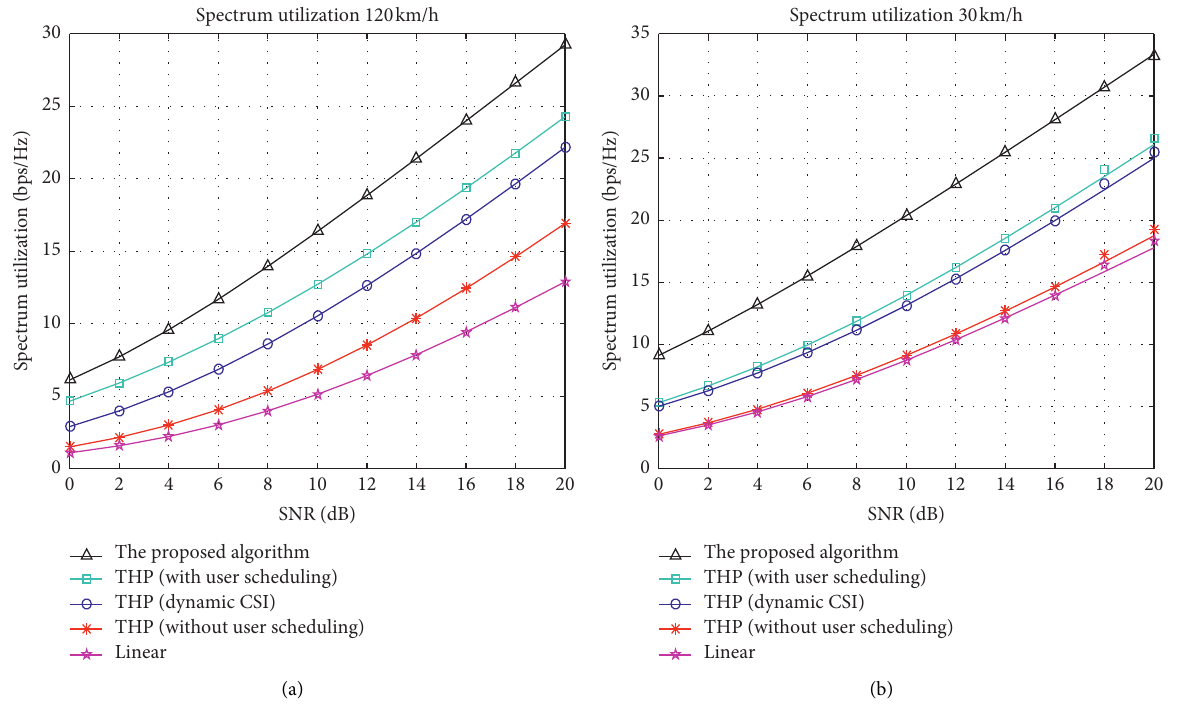
Figure 5: Spectrum utilization of several precoding algorithms: (a) 120km/h; (b) 30km/h.